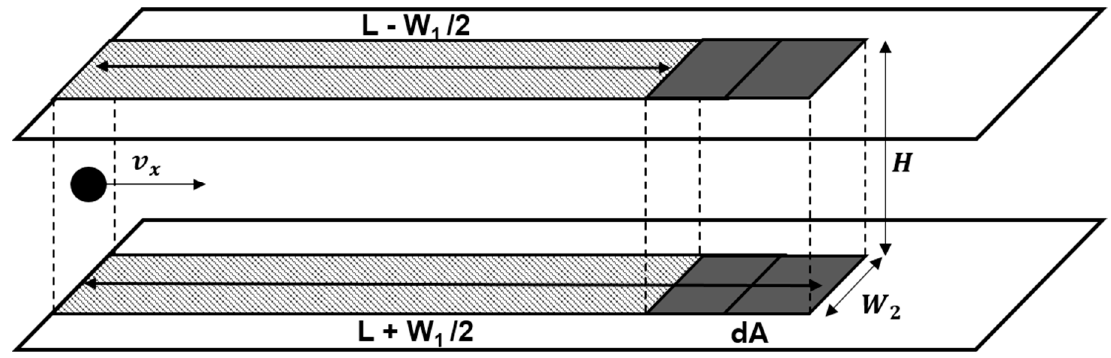
Figure 5. Geometrical configuration of mathematical model for analyte-receptor binding on microscopic area of a model description.